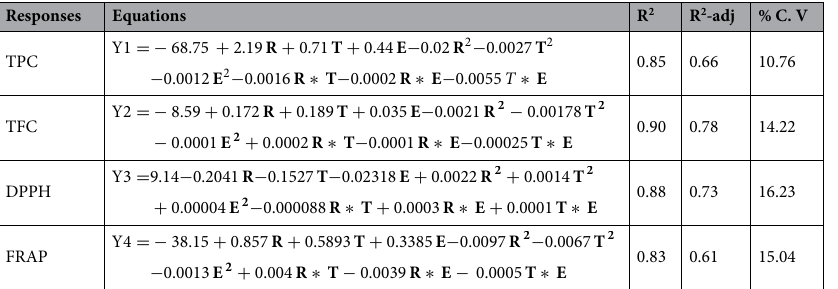
Table 3. Designed equation models for the selected dependent variables Responses. R ratio, T temperature, E extraction time, %CV coefficient of variation.